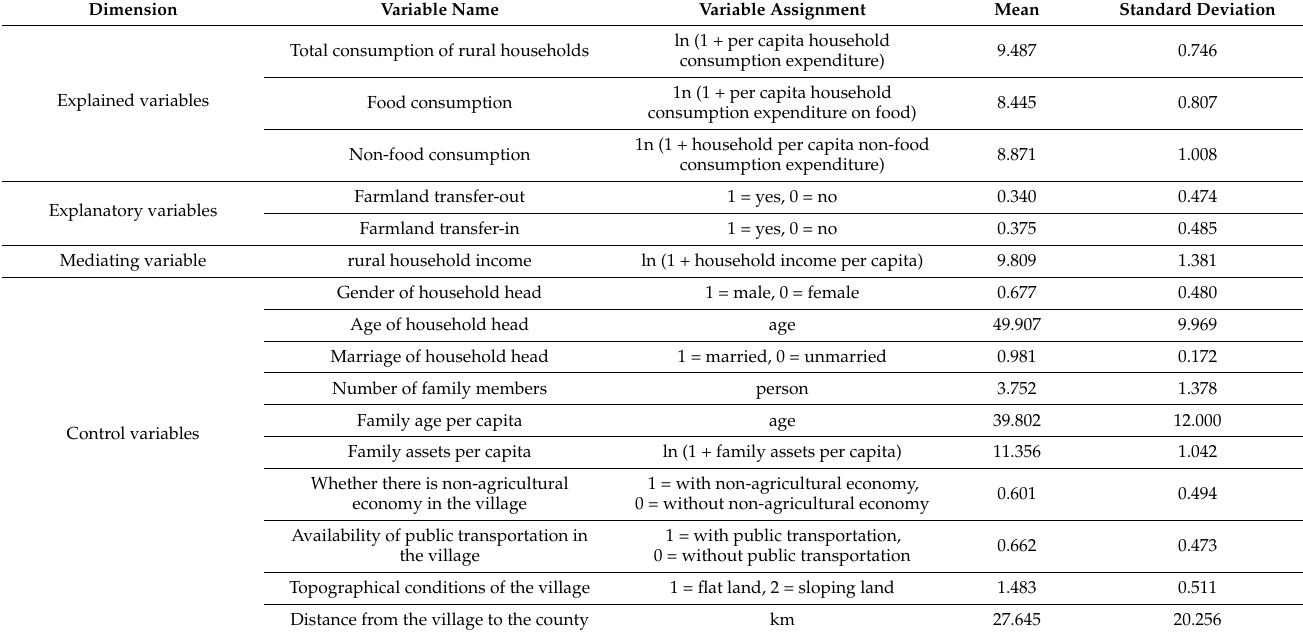
Table 1. Variable definitions and descriptive